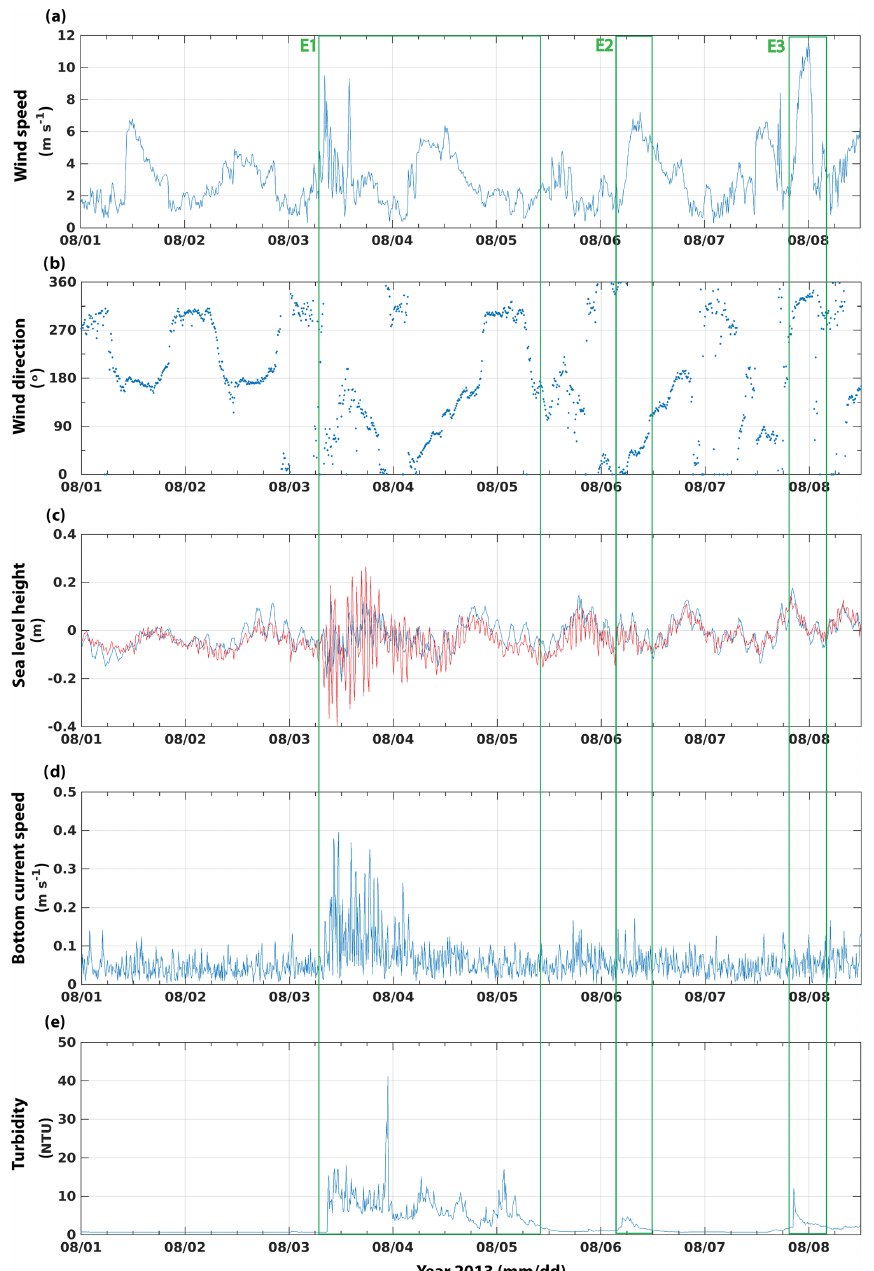
Figure 2. Time series of the variables measured during the field campaign. (a) Wind speed measured at M-Sc. (b) Wind direction measured at M-Sc. (c) Sea-level height measured at A2 (blue) and A1 (red). (d) Near-bottom current speed measured at A1. (e) NTU measured by OBS mounted at the A2 station. Vertical bars show the episodes considered in the